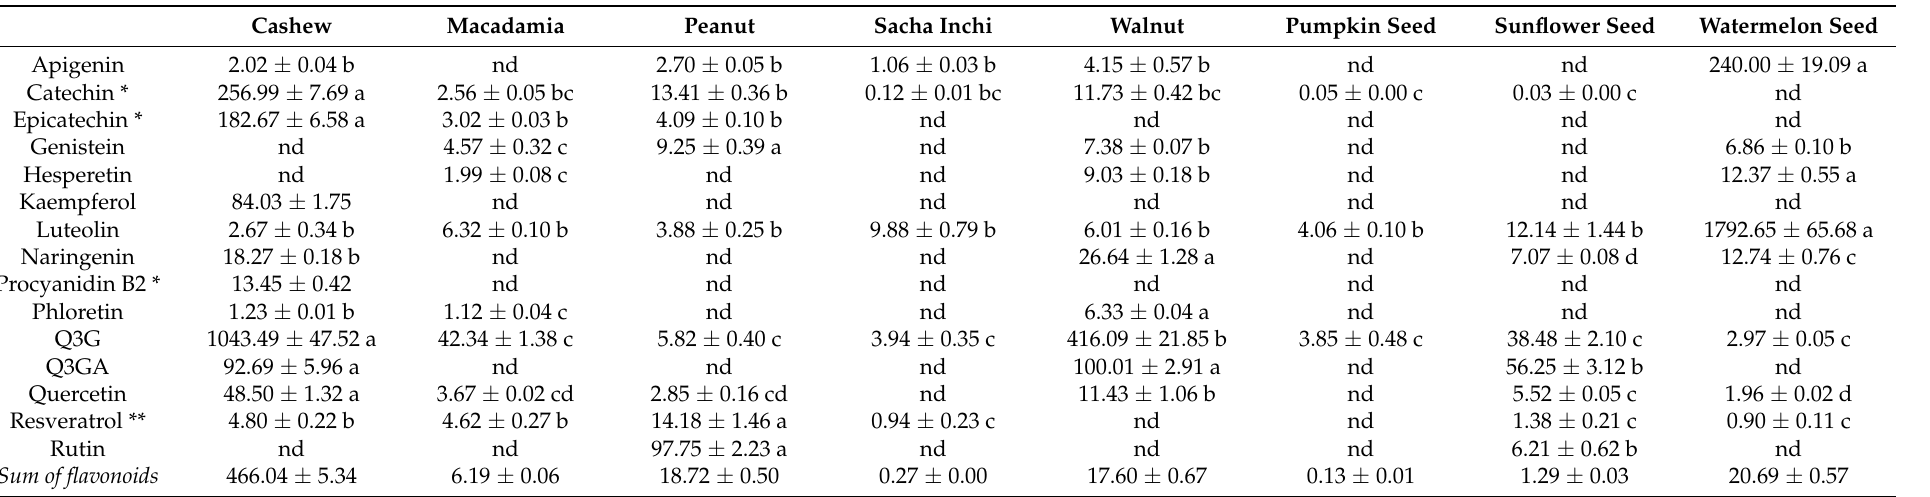
Table 3. Flavonoids ( µ g/100 g FW) of the studied nuts and